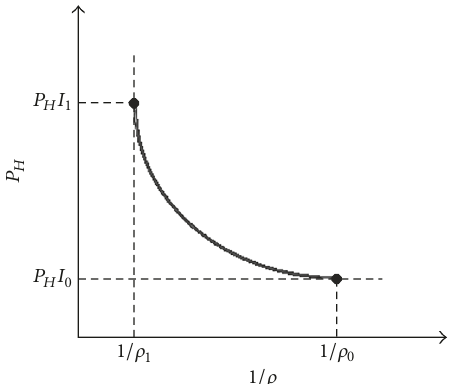
Figure 1: Schematic representation of a Hugoniot curve